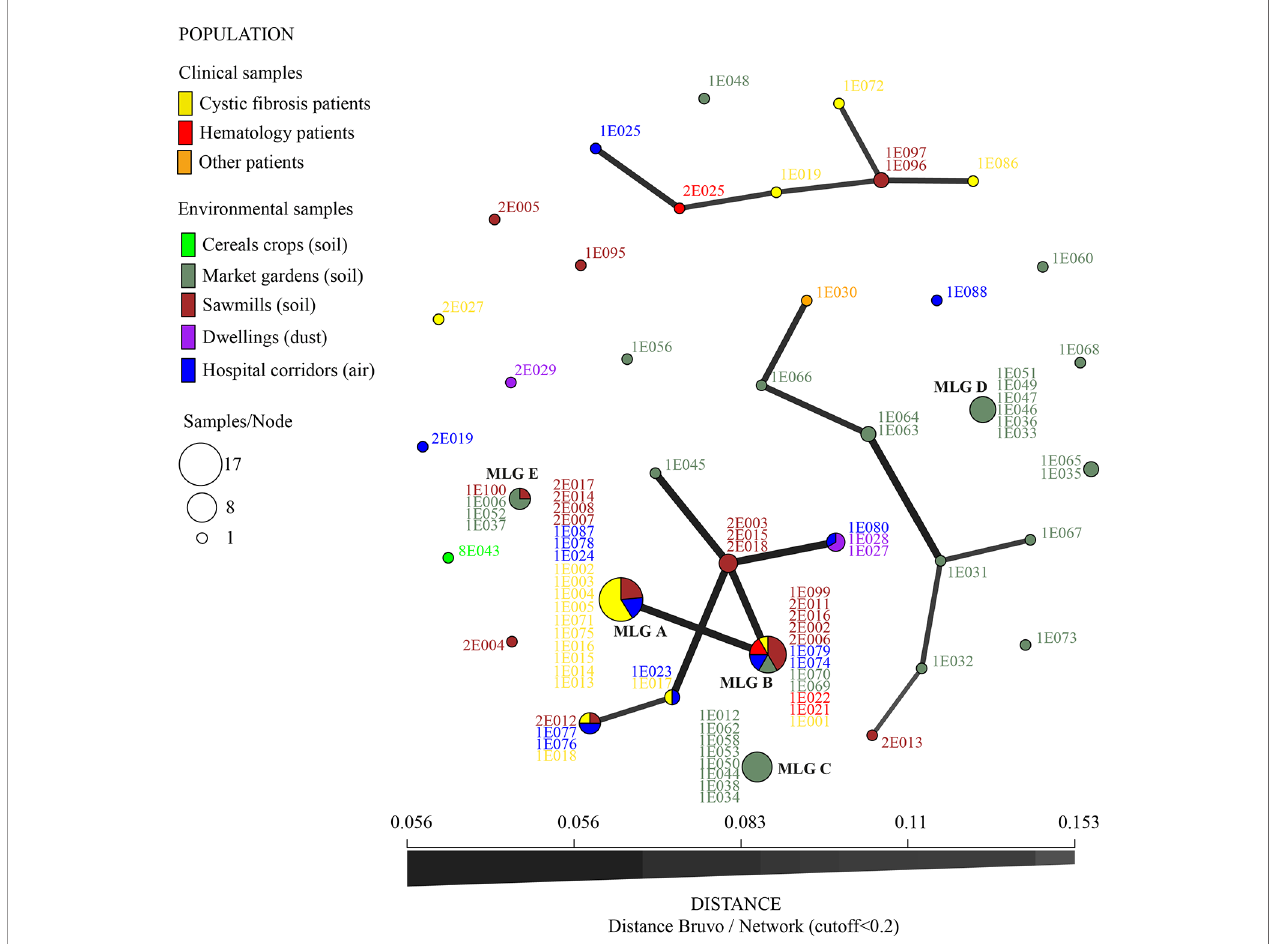
FIGURE 3 | Minimum spanning network for TR34/L98H isolates (nine microsatellite loci STRAf using Bruvo ’ s distance, with distance cutoff < 0.2). Colors represent the origin of sampling and numbers are ID isolates. Link thickness is proportional to genotype similarity. The most common multilocus genotypes (MLG) are denoted by the letters A, B, C, D, and